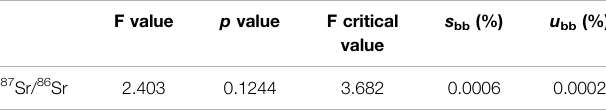
TABLE 4 | ANOVA data from the homogeneity study for the Sr